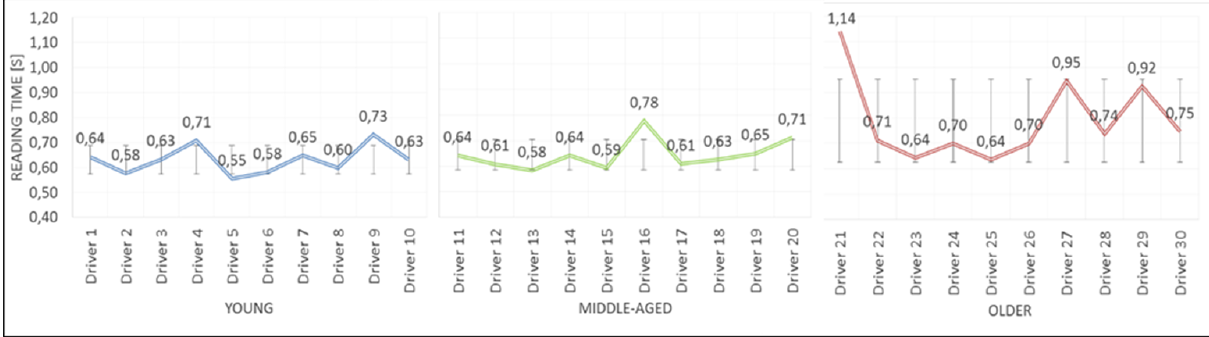
Figure 3. Reading times per word by age group. Reading times appear similar for young and middle-aged drivers, while they differ widely for elderly drivers. The statistical significance of this result was verified using the